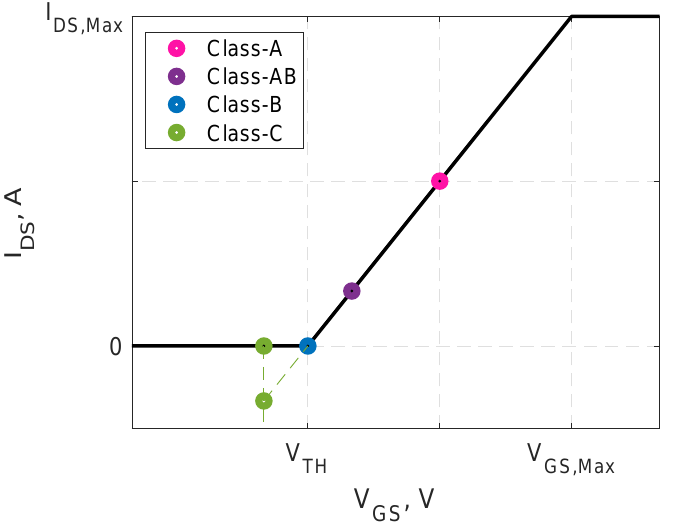
Figure 2. Bias points corresponding to the 4 possible biasing classes of Table1 on the trans- characteristic. For the class-C case the equivalent negative current is also